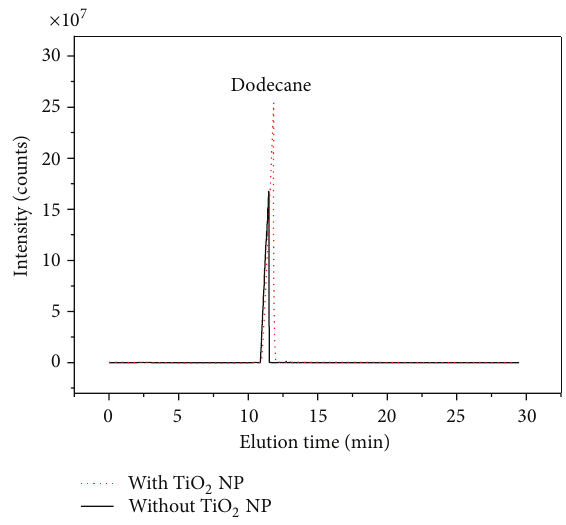
Figure 10: GC-MS chromatograms obtained for dodecane-loaded polyamide microcapsules adsorbed with N-doped TiO 2 nanoparti- cles (NP700), with and without UV-A irradiation.